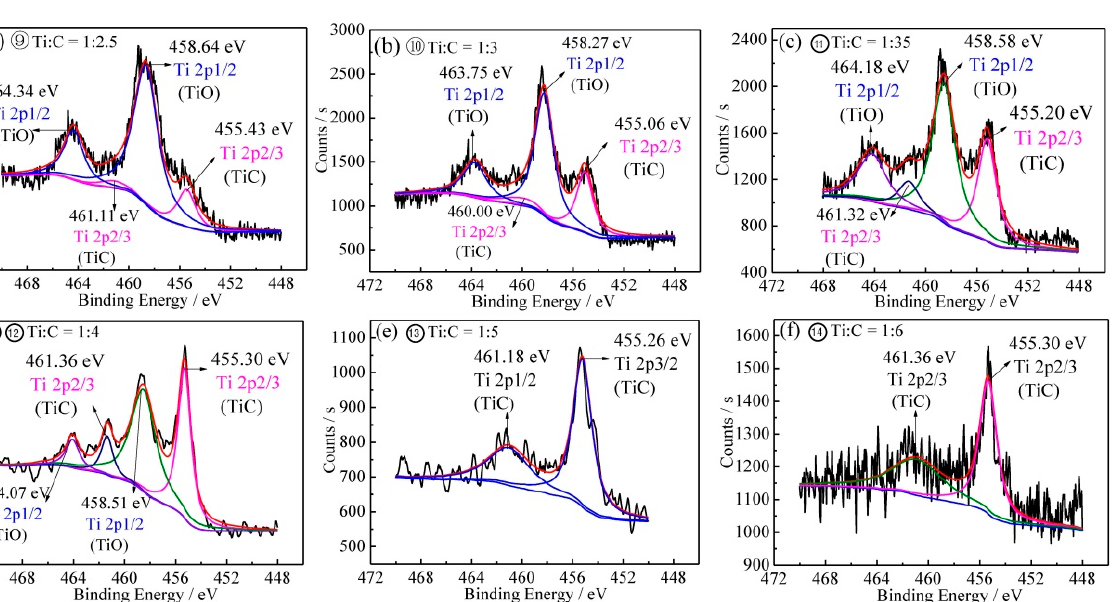
Figure 6. Ti 2P binding energy spectra ( a – f ) of the reduction product of samples 9–14 with different carbon contents.